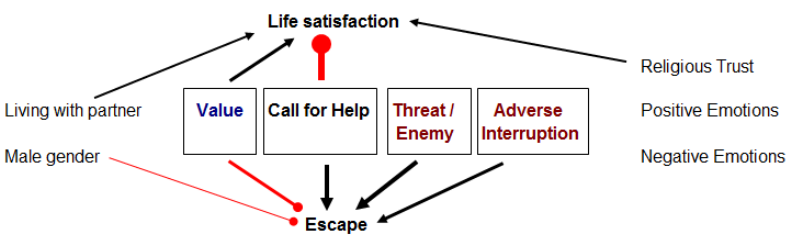
Figure 1. Interaction model with respect to the regression analyses. Positive influences on the dependent variables on life satisfaction or escape were indicated as arrow lines, while inhibitory influences were indicated as lines with thickened ends. The thickness of lines correspond with the T values of the regression models. Round ends indicate negative influences, while arrowed ends indicate positive